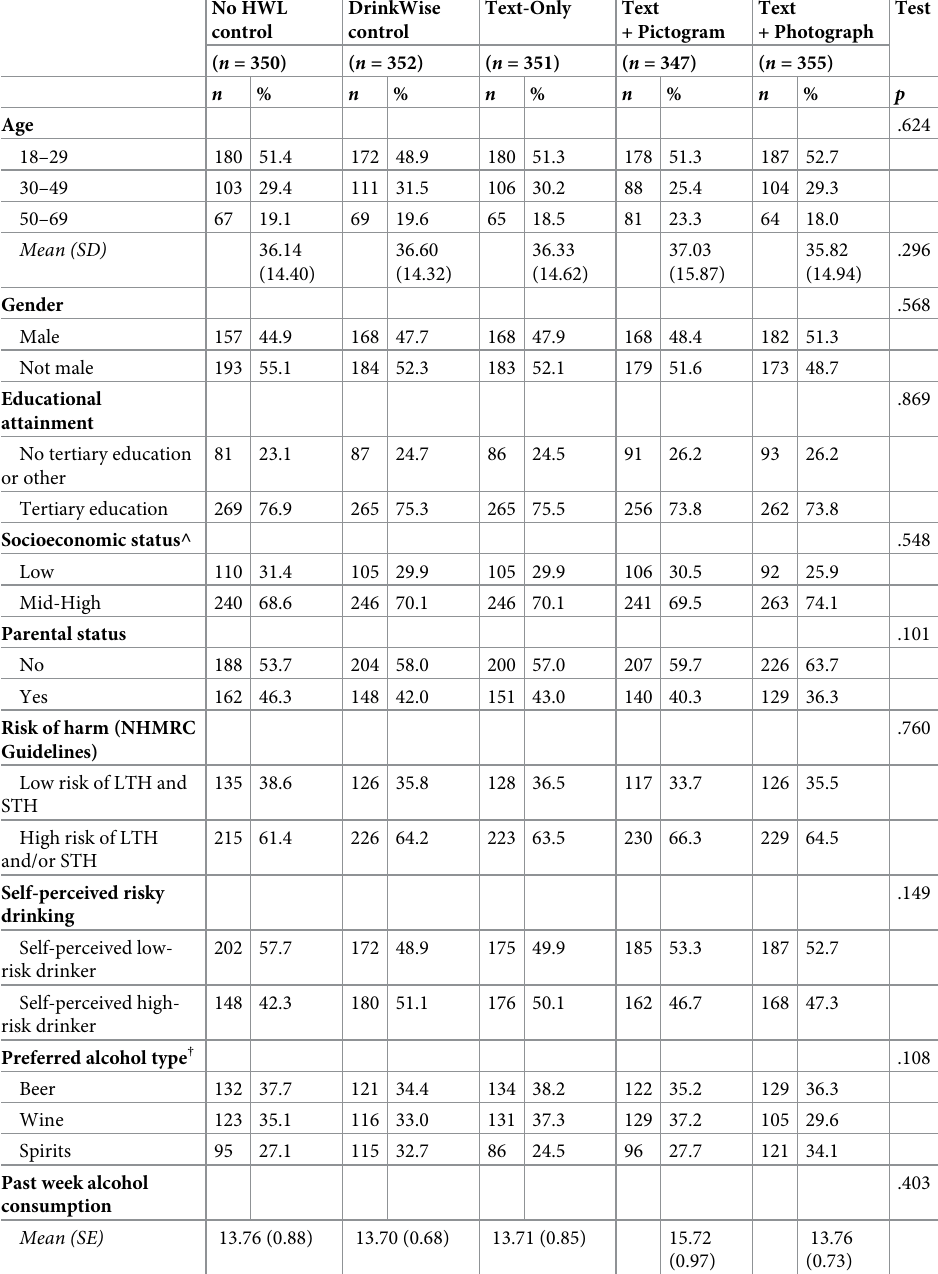
Table 1. Sample characteristics by condition at pre-exposure and between-condition test results ( N =